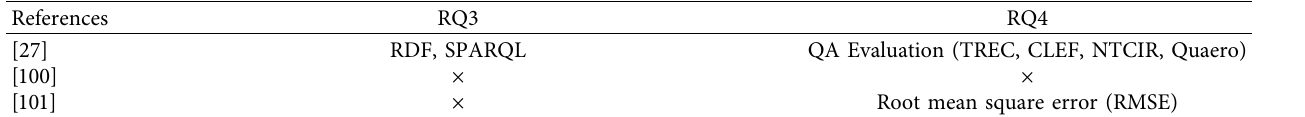
Table 9: Summary of Semantic Web technologies used in frontier technology.